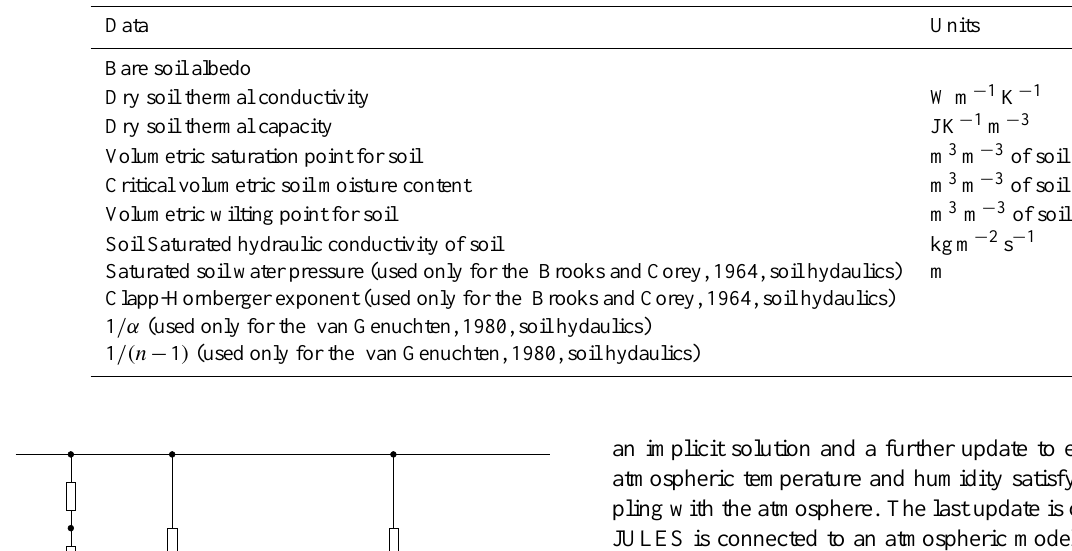
Table 3. Soil ancillary data required by the JULES model.